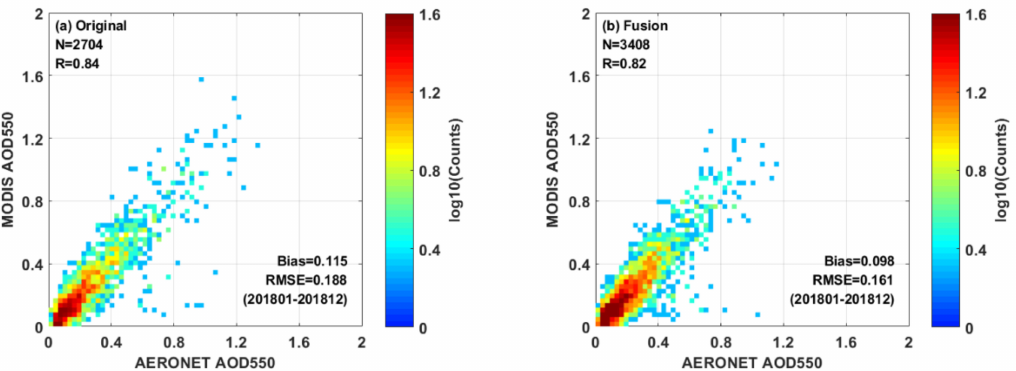
Figure 2. Validation results of total data for ( a ) original MAIAC AOD and ( b ) fusion MAIAC AOD. The color bar presents counts of points. Number of samples (N), correlation coefficient (R), RMSE, and bias are given in each